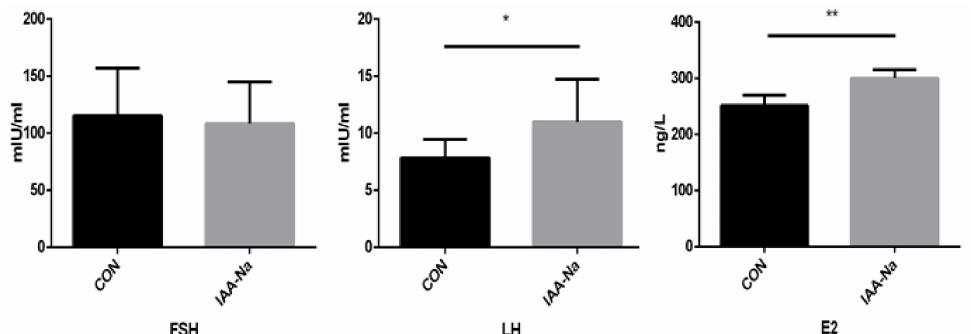
Figure 1. Effect of dietary IAA-Na supplementation on serum hormone levels in Danzhou chickens. Note: CON = basal diet, and IAA-Na = basal diet plus 200 mg/kg diet sodium